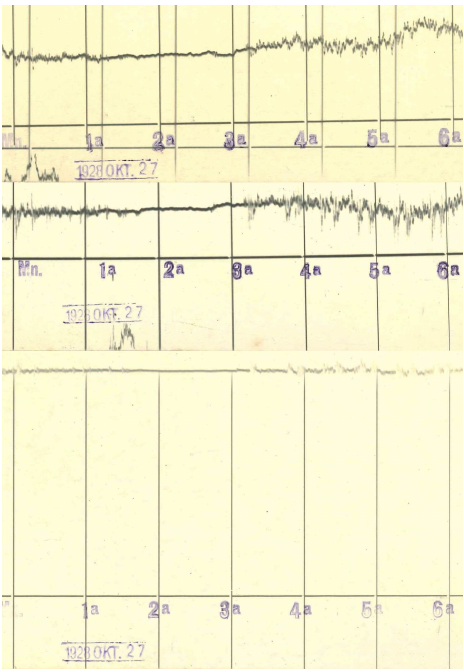
Figure 10. Potsdam Observatory photographic recordings of the horizontal intensity (top), declination (middle) and vertical inten- sity (bottom) of the time interval of 27 October 1928 at 00:00 till 27 October 1928 at 06:00 (Greenwich civil mean time), showing the disturbing effect of the Berlin suburban railway service. Source: Helmholtz Centre Potsdam –